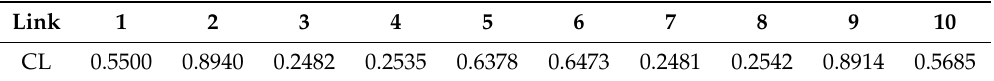
Table 1. Mean congestion level (CL) on links from simulated OD